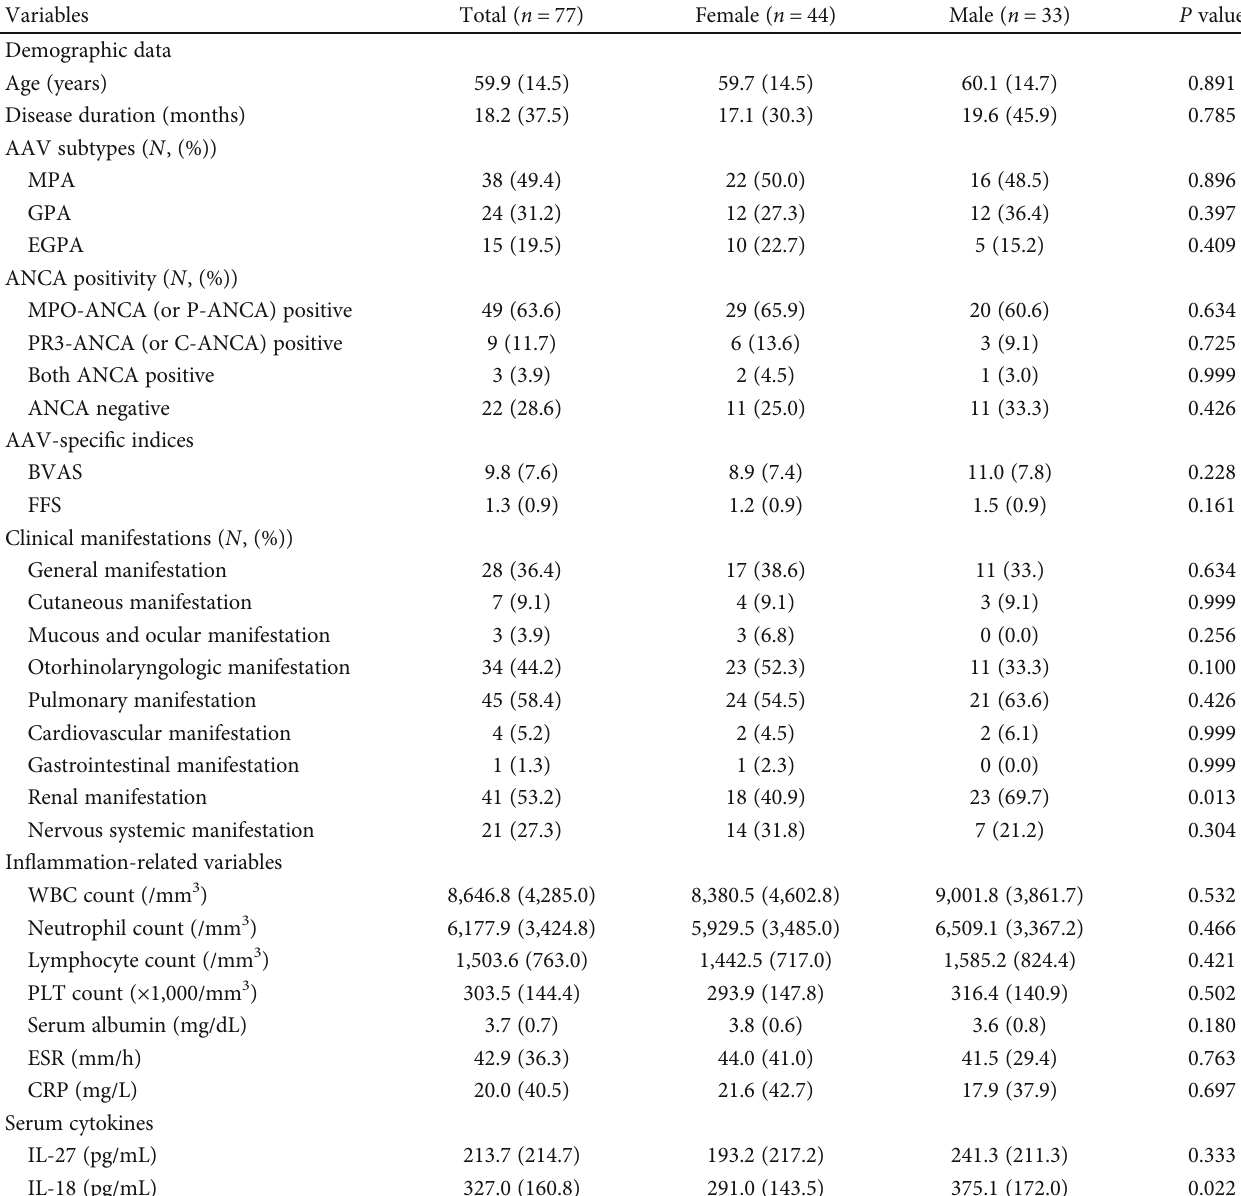
Table 1: Characteristics of 77 patients with